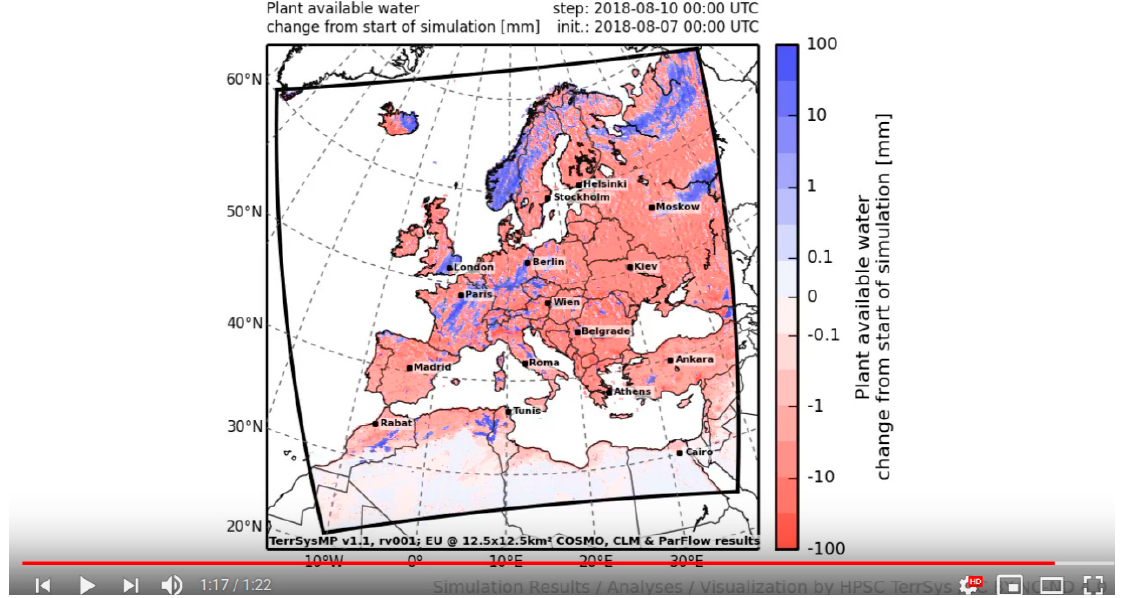
Figure 7. Monitoring output of TSMP (CORDEX EUR-11 domain) of the change of plant available water (mm) over the course of the prediction period of 72 h (between 7 August and 10 August 2018).